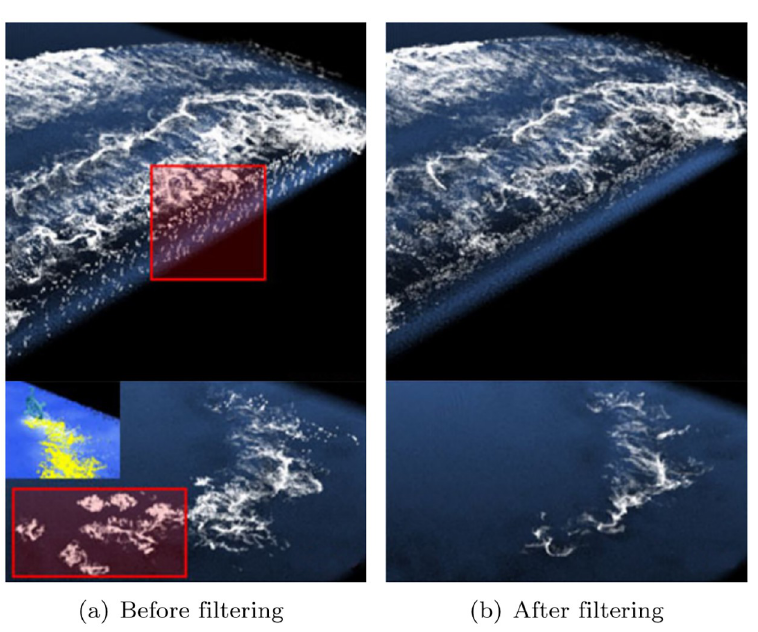
Fig 3. The filtering technique used in the previous methods [22, 23] (red box: Noise area). (a) Before filtering, (b) After filtering.